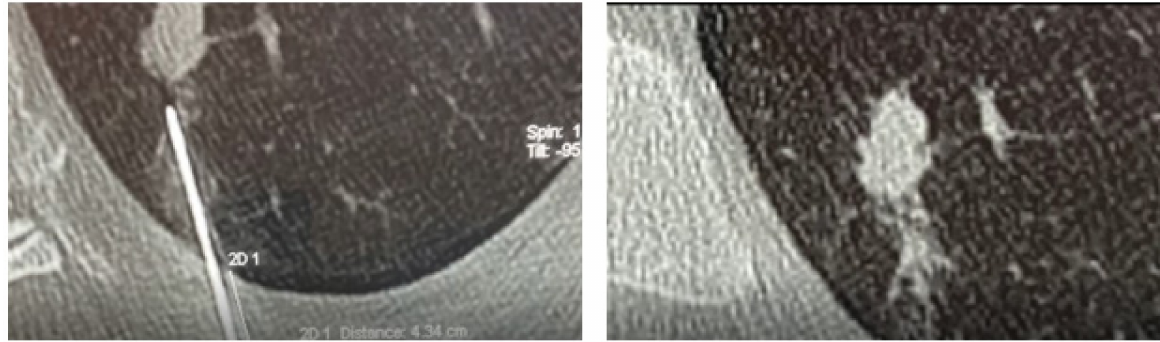
Figure 2. A CT scan showing the plug